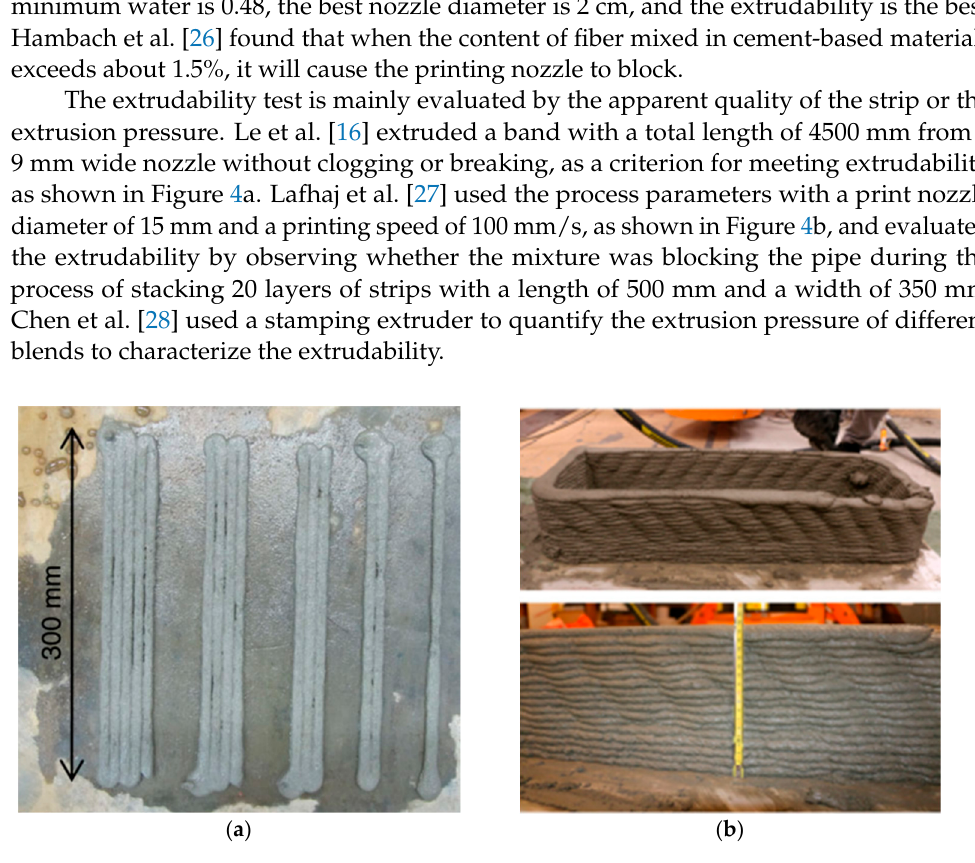
Figure 4. Test sample to evaluate extrudability. ( a ) Long strip evaluation chart. ( b ) Stacking evaluation chart,